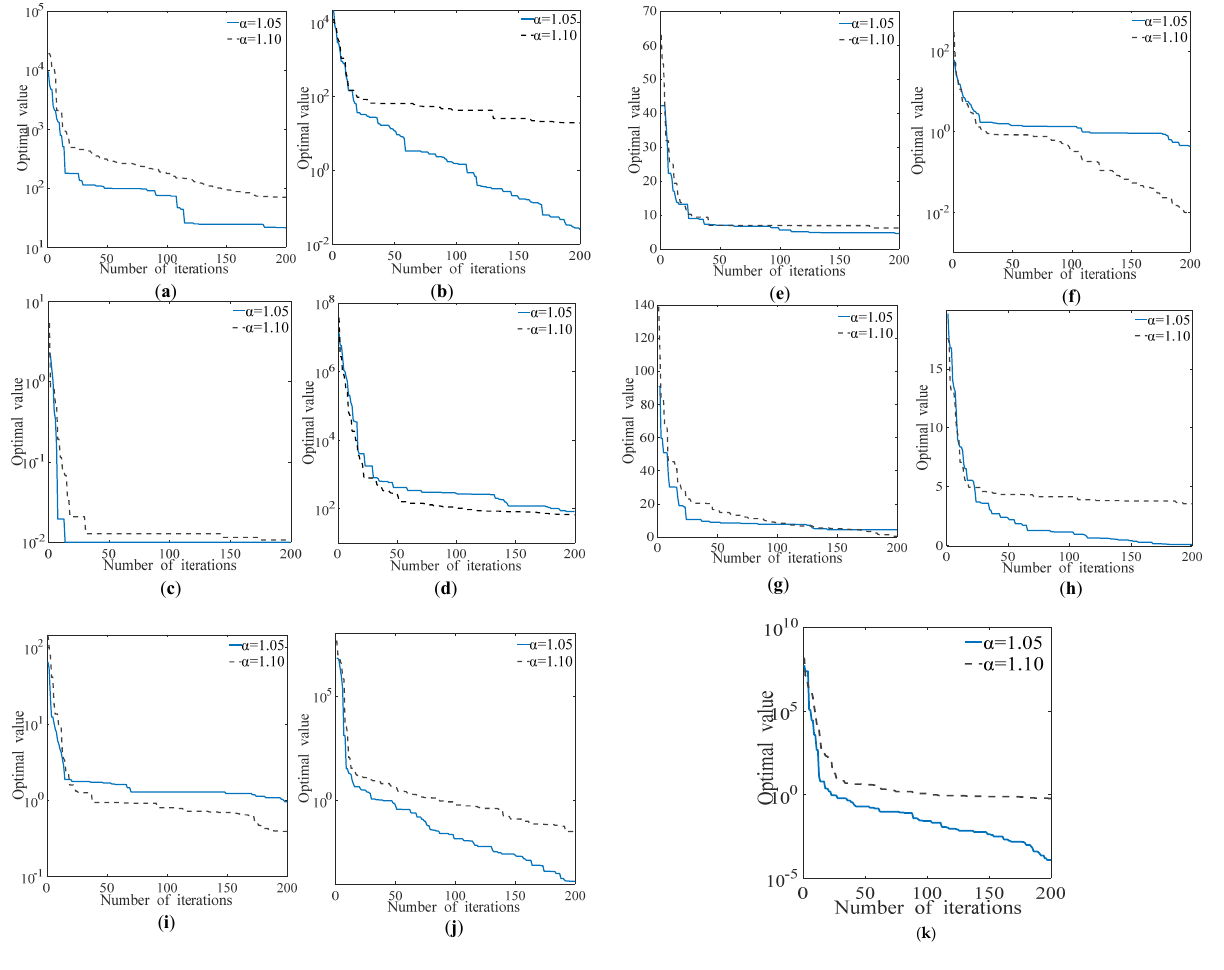
Figure 5. Comparison of different α values in the HDBBO algorithm ( a – k ) on the convergence of f 1 − f 11 .( a ) convergence of different α on benchmark function f 1 ; ( b ) convergence of different α on benchmark function f 2 ; ( c ) convergence of different α on benchmark function f 3 ; (d) convergence of different α on benchmark function f 4 ; ( e ) convergence of different α on benchmark function f 5 ; ( f ) convergence of different α on benchmark function f 6 ; ( g ) convergence of different α on benchmark function f 7 ; ( h ) convergence of different α on benchmark function f 8 ; ( i ) convergence of different α on benchmark function f 9 ; ( j ) convergence of different α on benchmark function f 10 ; ( k ) convergence of different α on benchmark function f 11 . The solid and dotted lines in Figure 5 represent the convergence curves of the func- tions when 1.05 α= and 1.10 α= , respectively. When 1.10 α= f , f , and f 4 6 9